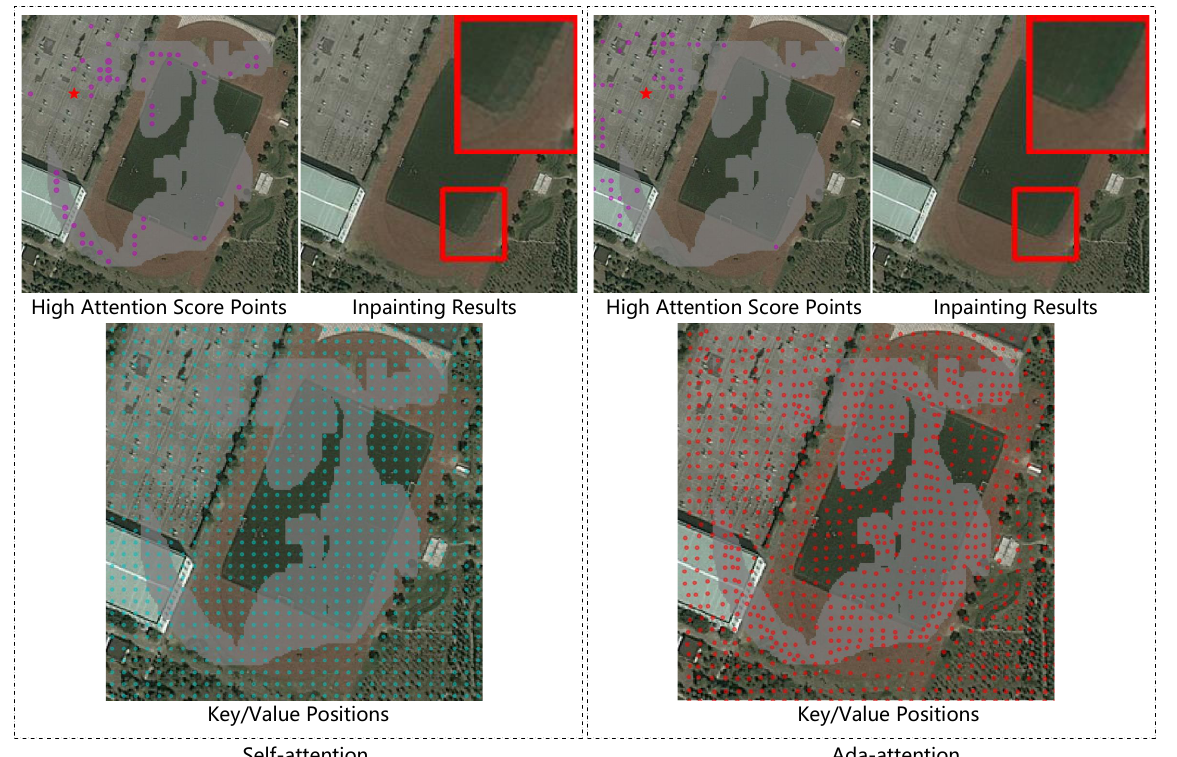
Figure 1. Illustration of self-attention and Ada-attention, including high-attention-score points, key/value positions, and inpainting